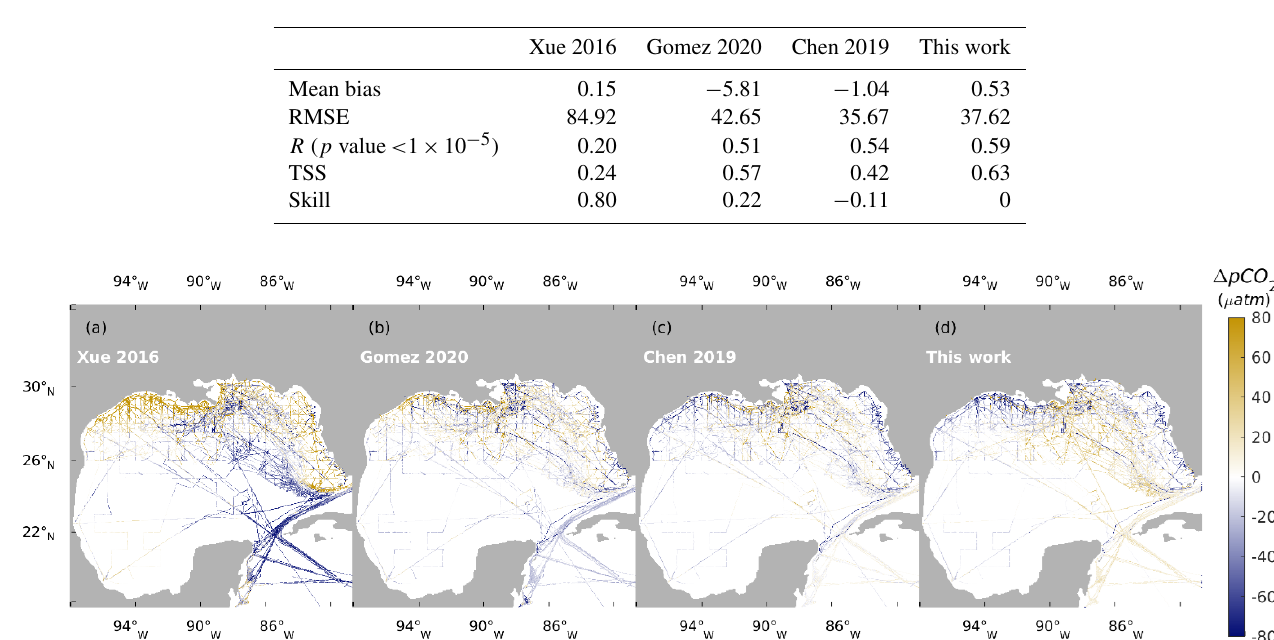
Figure 15. Comparison of sea surface p CO 2 between regional ocean model products (Xue 2016, Gomez 2020, Chen 2019, this work) and underway sea surface p CO 2 measurements. A positive (cid:49)p CO 2 indicates that the product data overestimate sea surface p CO 2 . A negative (cid:49)p CO 2 suggests that the product data underestimate sea surface p CO 2 . A neutral (cid:49)p CO 2 indicates that the product data agree well with the observed sea surface p CO 2 . The white spaces between the cruise lines indicate that these regions do not have observational p CO 2 data and do not indicate neutral